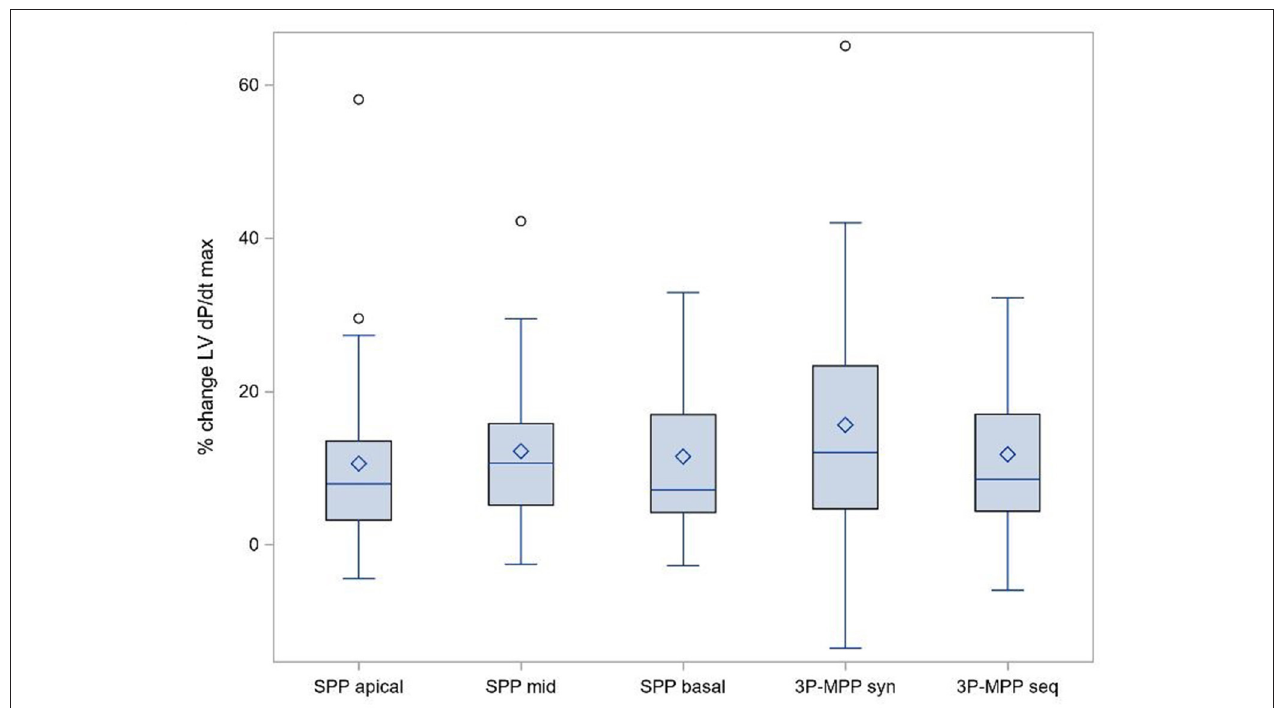
FIGURE 3 | Primary objective: % 1 LV + dPdt max boxplot at best AV-delay. SPP, RV-LV Single-point pacing and MPP, RV-LV Multi-point pacing. MPP seq , Sequential MPP; MPP syn , Synchronous (simultaneous) MPP; SPP basal,mid,apical , SPP from base, mid, apical LV electrode. Solid line depicts the median value, and boxes are 25th and 75th percentile. Whiskers represent the most extreme data point within 1.5x interquartile range from the boxes. Diamonds represent mean value, and dots are